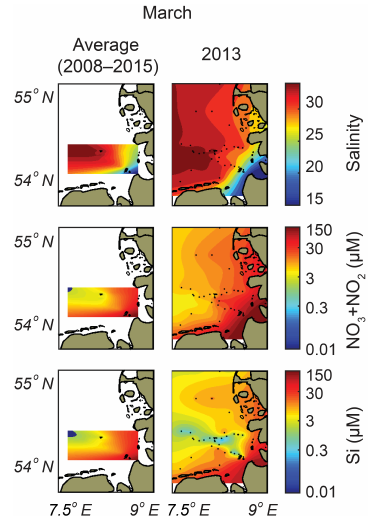
Figure 9. pH ferry data between Büsum and Helgoland for each summer between 2008 and 2014. There were two pH probes avail- able on the ferry M/V Funny Girl . The white sections represent times when data were not available.